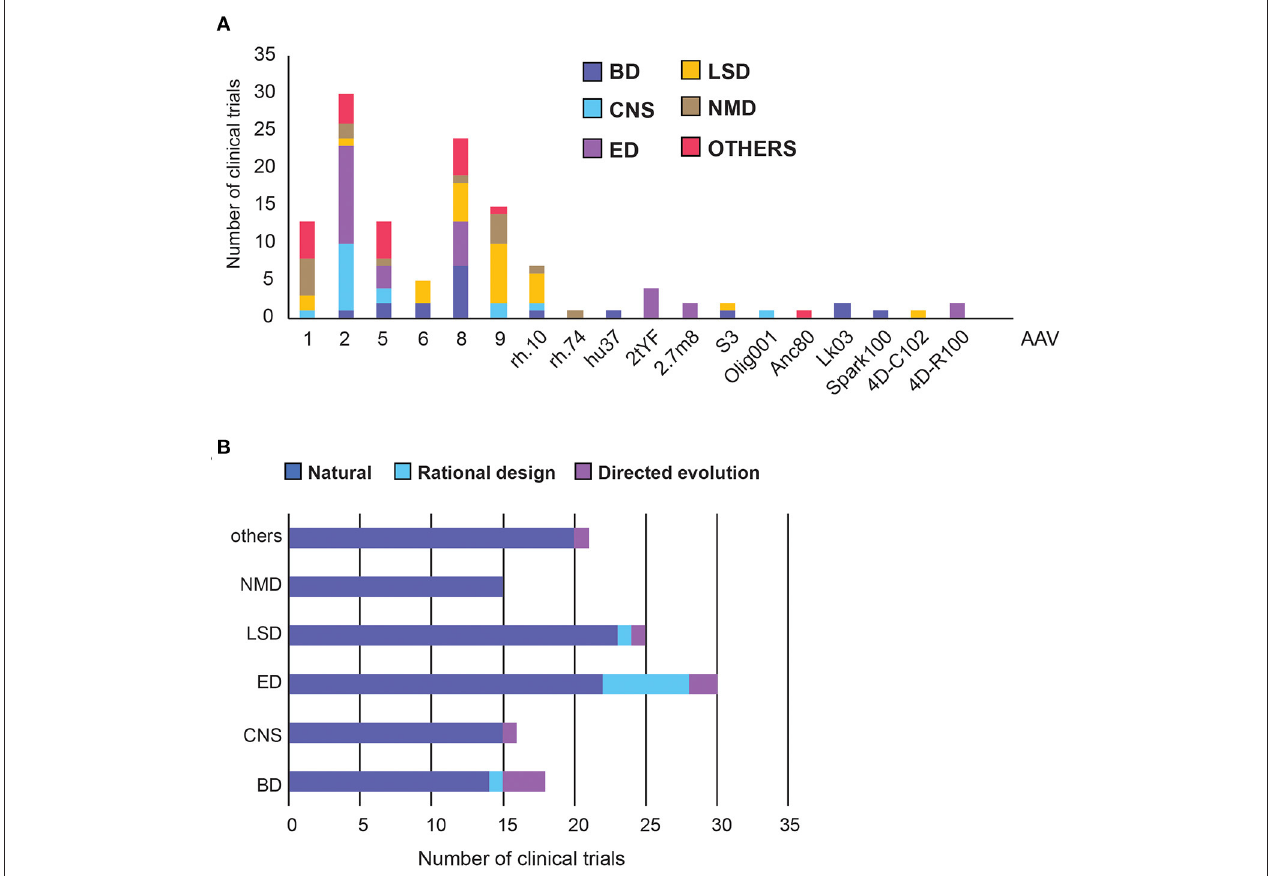
FIGURE 4 | Adeno Associated Virus (AAV) capsid usage and frequency in clinical trials. (A) Overall AAV capsid type usage across all clinical trials. (B) Capsid design across therapeutic areas. BD, Blood disorders; CNS, Central Nervous System; ED, Eye Disorders; LSD, Lysosomal storage disorders; NMD, Neuromuscular Disorders. The list of capsid descriptions can be found in Supplementary Table 2 , Supplementary Figure 1